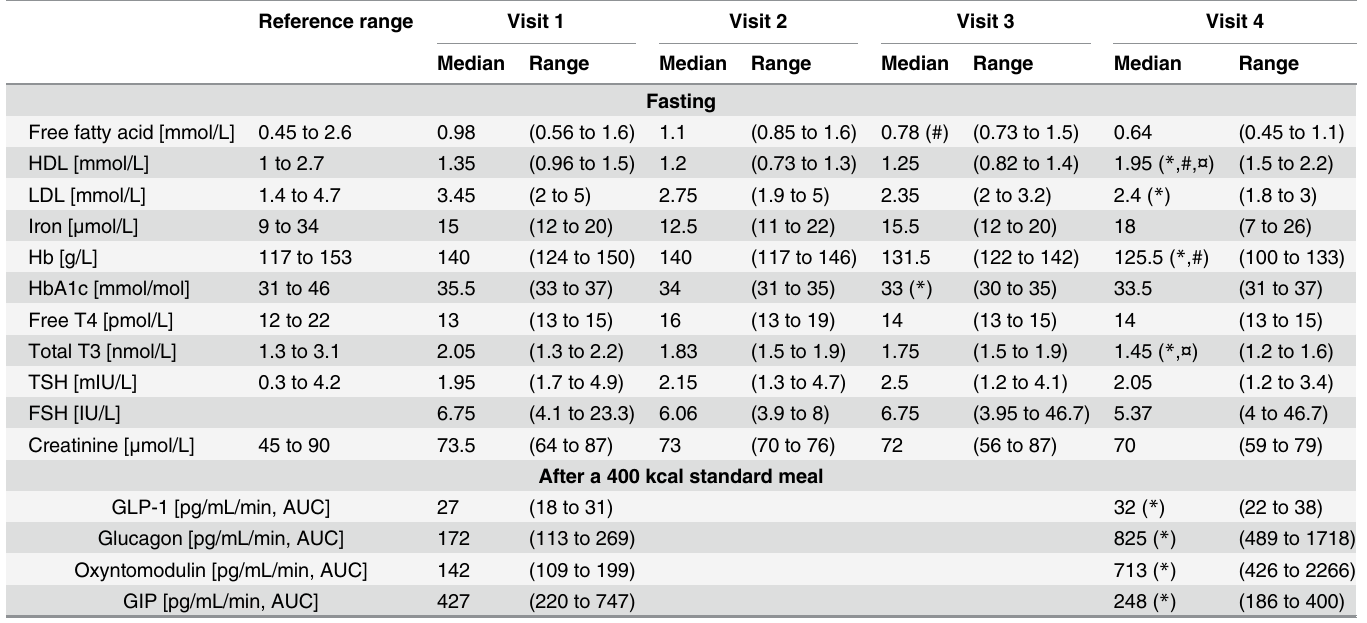
Table 2. Biochemical variables in six females before and 20.3 months after Roux-en-Y gastric bypass surgery. Reference